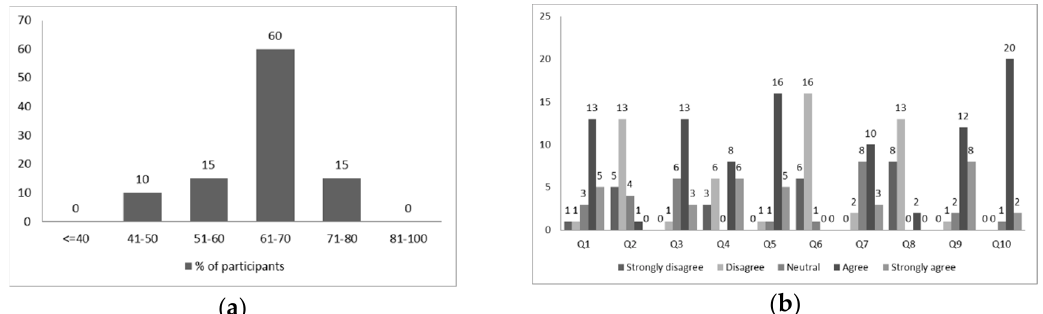
Figure 6. Results of the initial evaluation with SUS: ( a ) SUS scores; ( b ) SUS questionnaire responses.